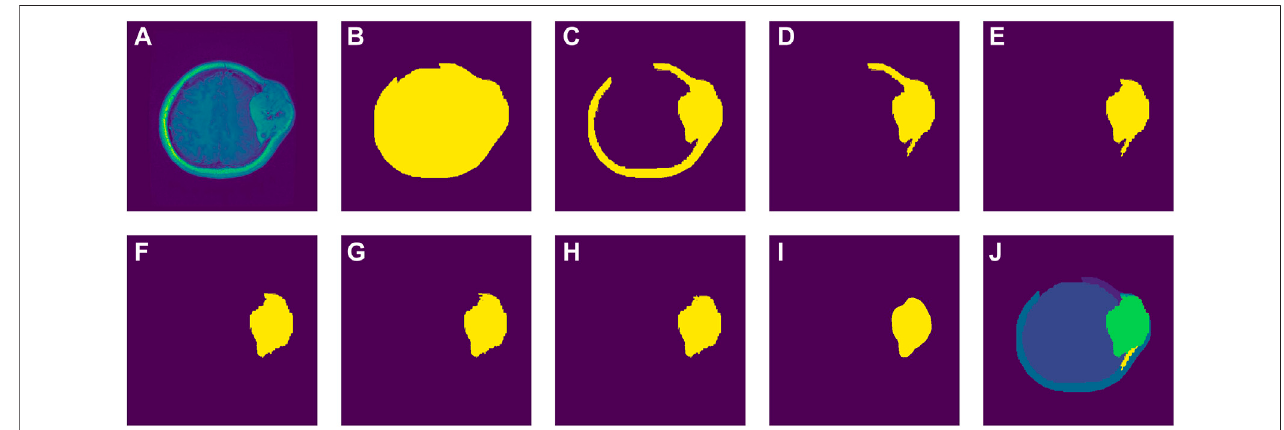
FIGURE 7 | Segmenting a brain tumor that is strongly connected to the skull. (A) Representative axial MRI section of a brain with a tumor giving a higher intensity signal. (B – G) Segmenting the brain tumor interactively sigma = 0.9. (H) Segmented image using minimum spanning tree. (I) Ground truth. (J) Visualized labels of the segmented tumor and the